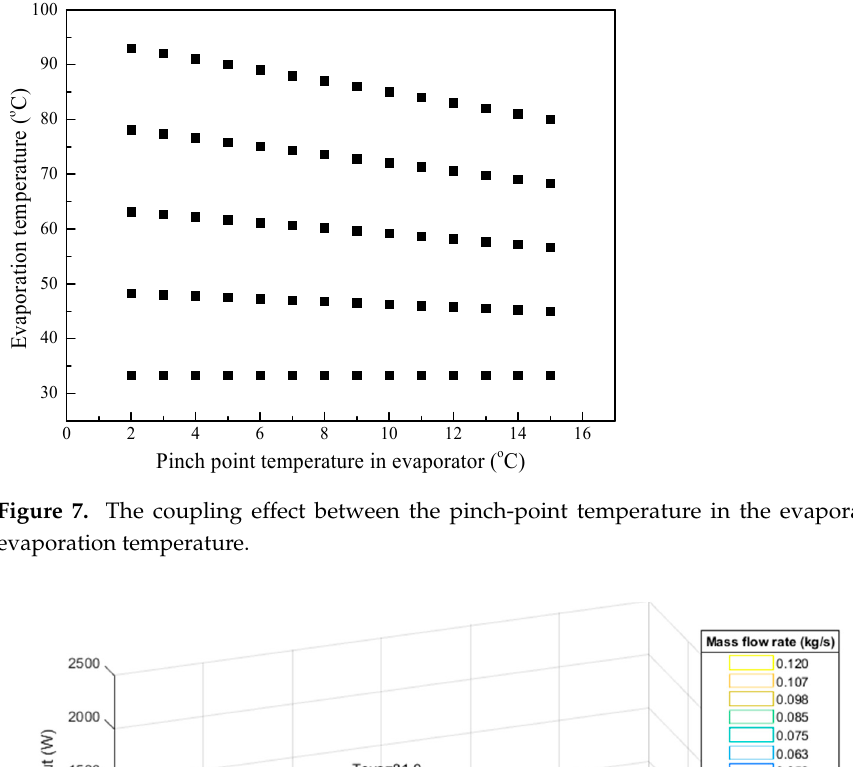
Figure 7. The coupling effect between the pinch-point temperature in the evaporator and the evap- oration temperature.